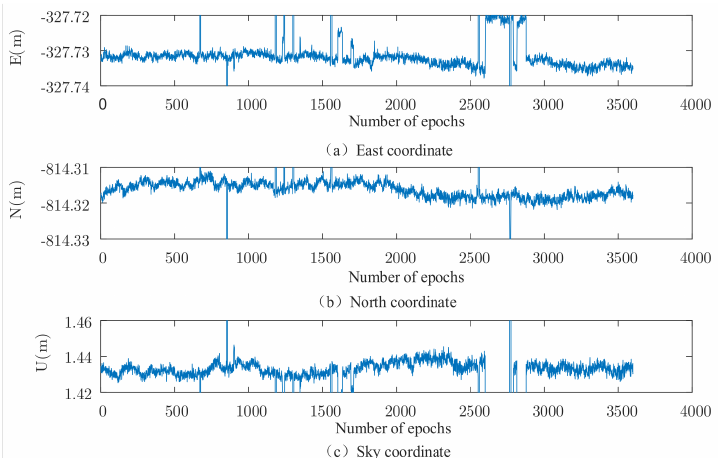
Figure 2. Measured data 1, traditional EKF three-dimensional baseline results.